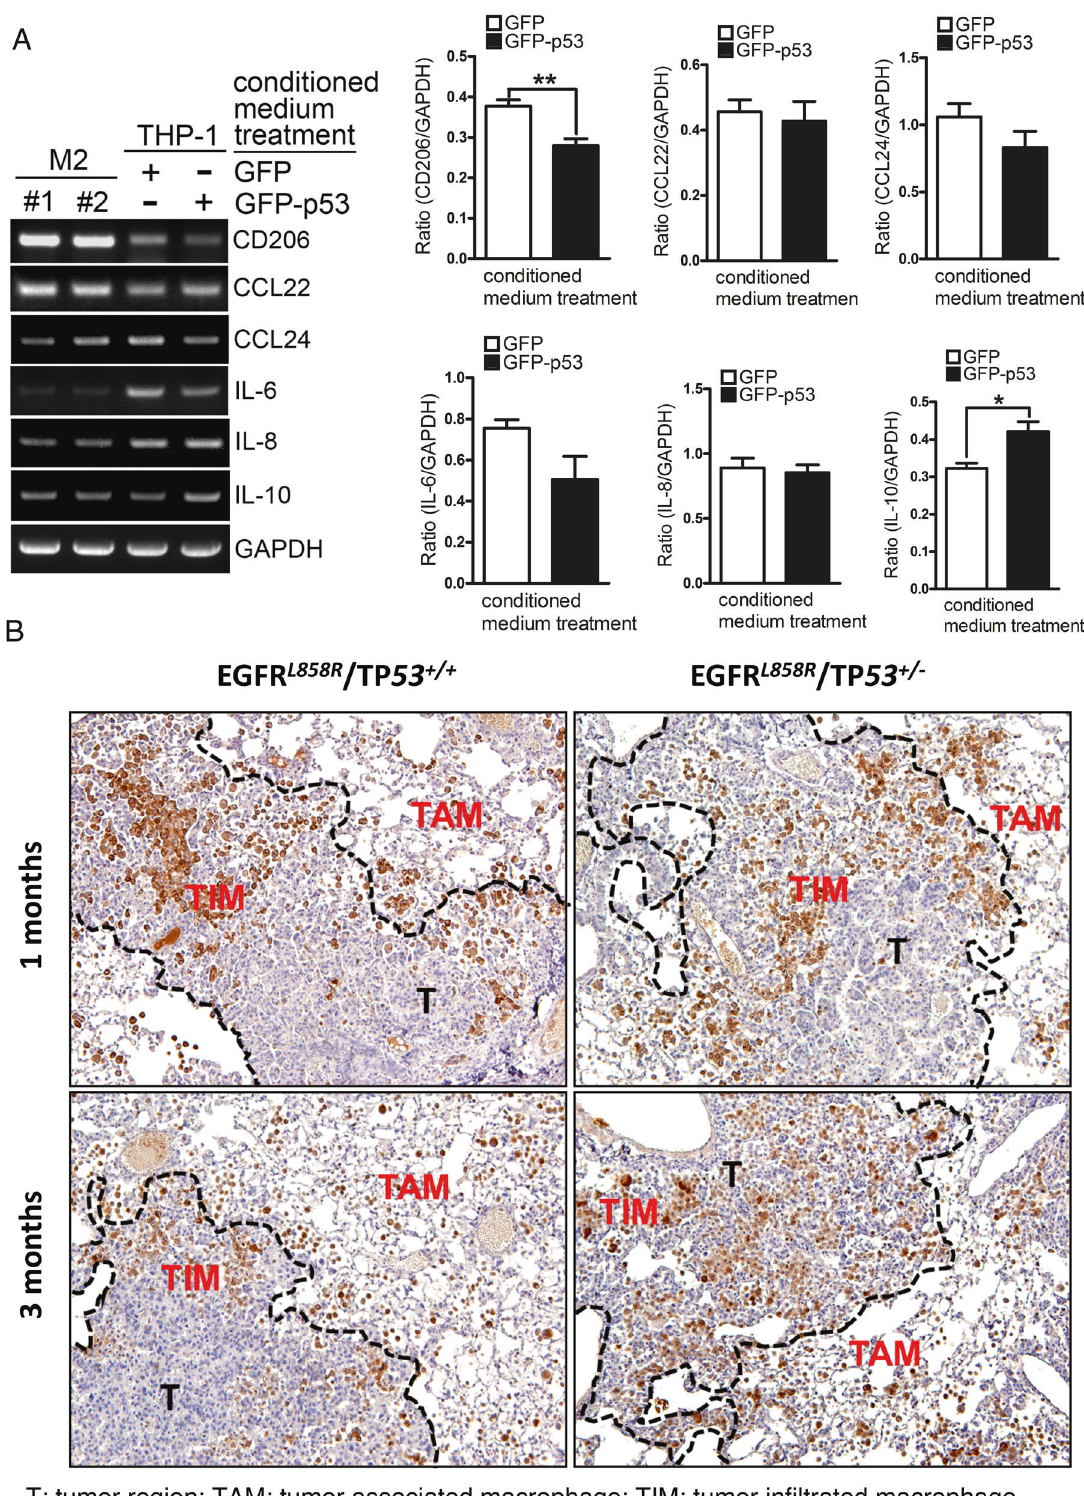
Fig. 4 p53 regulates the tumor-associated microenvironment (TME) of lung cancer cells. Total RNA was extracted from M2 macrophages and THP-1 cells treated with conditioned medium collected from H1299 L858R cells with or without GFP-p53 overexpression to study the mRNA levels of the indicated genes by RT-PCR. After three independent experiments were completed, the mRNA levels were quanti fi ed and statistical assays were performed by a t tests; * P < 0.05, ** P < 0.01 ( A ). The distribution of M2 macrophages in the tumor microenvironment of mice with EGFR L858R - and EGFR L858R × TP53 − / + -induced lung cancer that were treated with 10 mg/ml doxycycline in water for 1 month ( B , upper panel) or 3 months ( B , lower panel) was studied by immunohistochemistry (IHC) with anti-YM1 antibodies. T tumor region, TAM tumor-associated macrophage, TIM tumor-in fi ltrated macrophage ( B